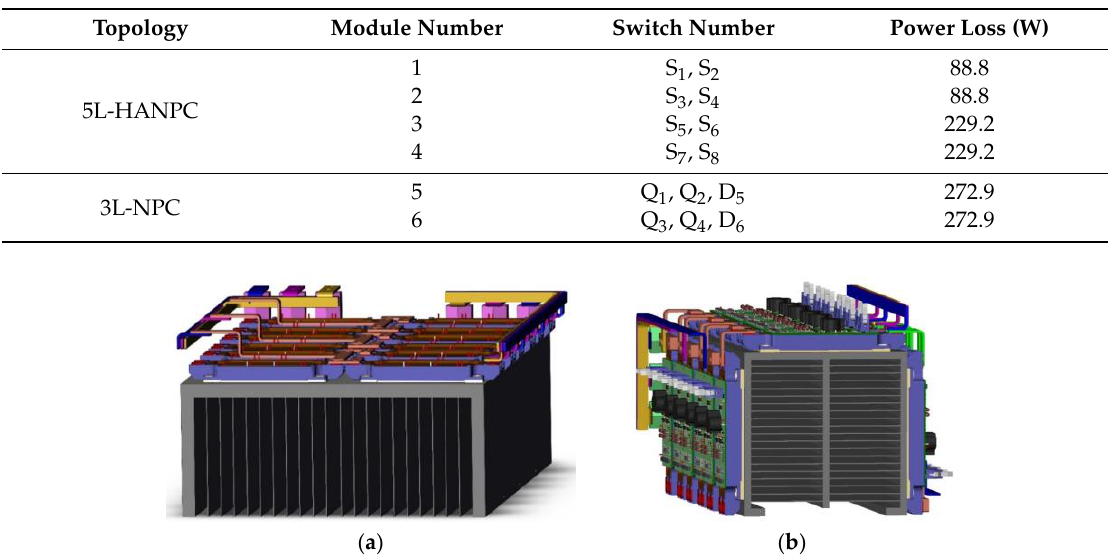
Figure 7. Heatsink design: ( a ) traditional planar structure; and ( b ) proposed triple-surface structure.